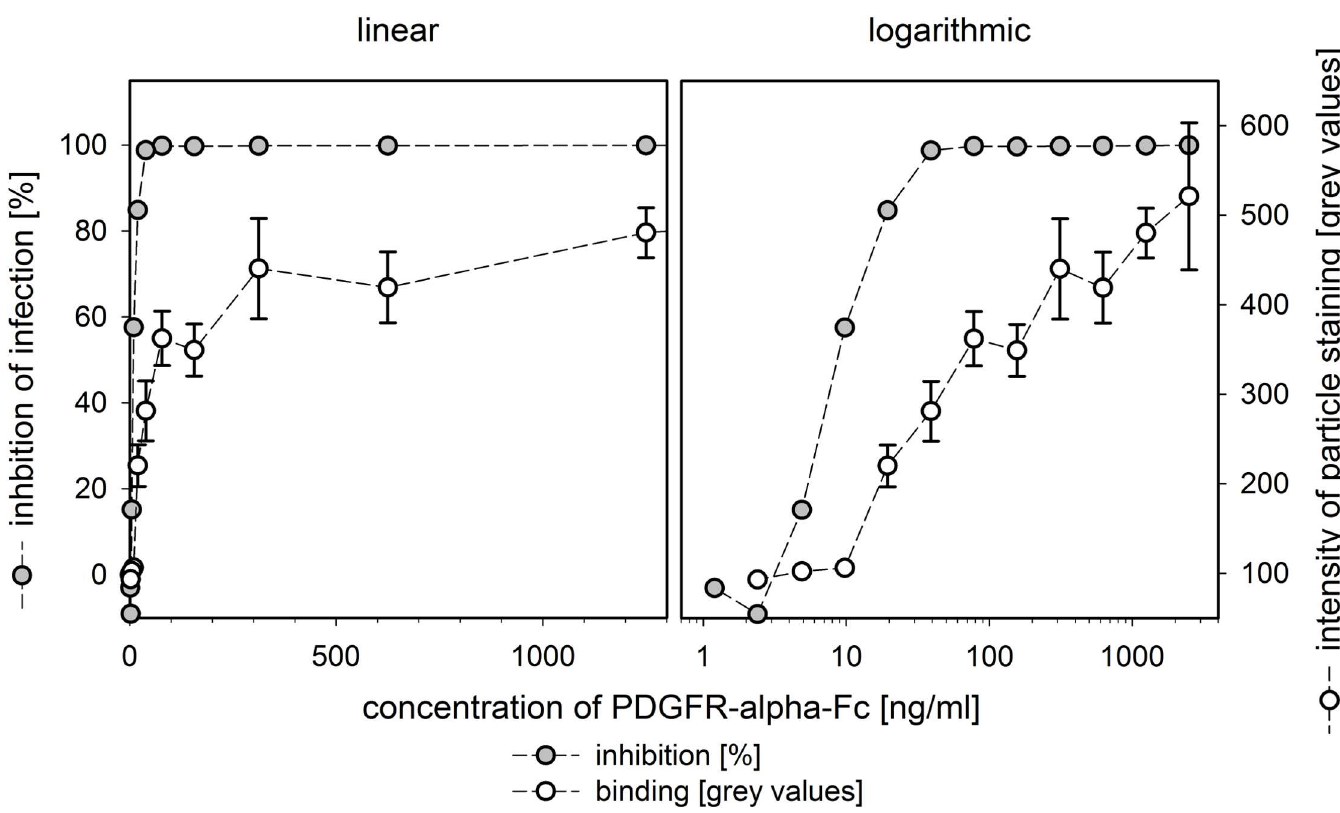
Fig 5. Quantification of PDGFR-alpha-Fc binding to HCMV particles. Virus preparations of strain TB40/E were preincubated with serial dilutionsof PDGFR-alpha-Fc. Viruses were attached to fibroblasts by incubation on ice for 90 min followedby acetonefixation. Bindingof PDGFR-alpha-Fc was assessedby direct immunofluorescenceof the Fc-fusion part and quantification of signalintensities(maximum grey values per particle). In parallel, fibroblasts were incubatedwith the same mixtures at 37˚C and stainedfor viral immediate-early antigens at one day postinfectionto determinethe fraction of infected cells. The intensity of the staining with PDGFR-alpha-Fc was measuredfor 100 particles in each condition. The same data set is provided with a linear scale and a logarithmic scale. Error bars indicatethe error of the median.